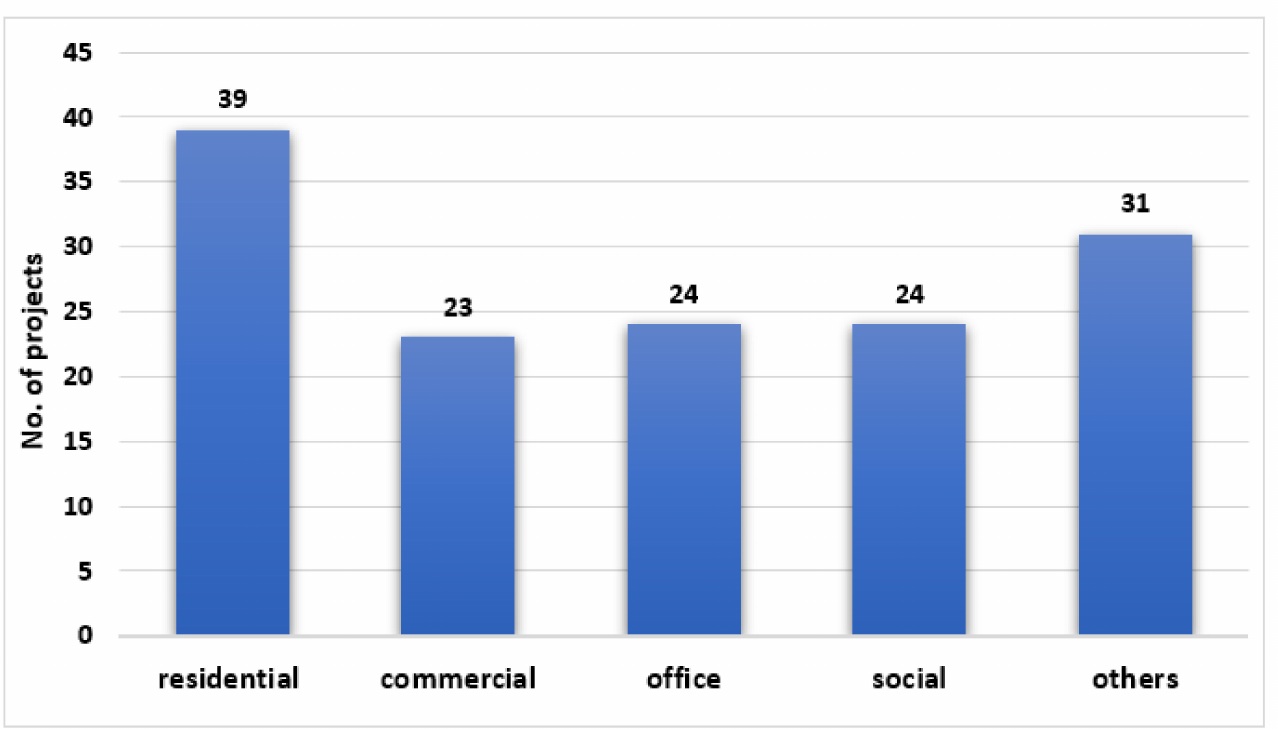
Figure 6. Type of buildings involved for space utilized by energy